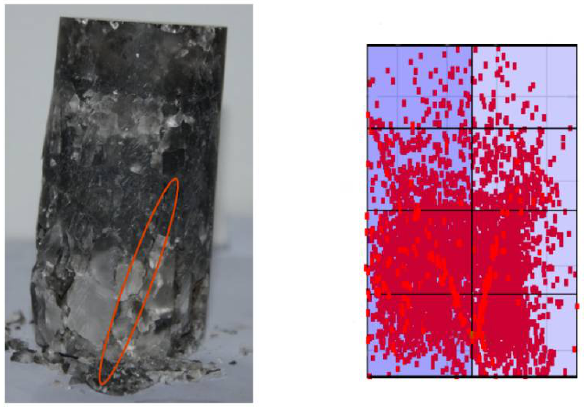
Figure 7. Comparison of damaged rock after uniaxial compression and AE event locations for sample SA-2. Table 2. Acoustic emission events of salt rock in different stages under uniaxial stress.